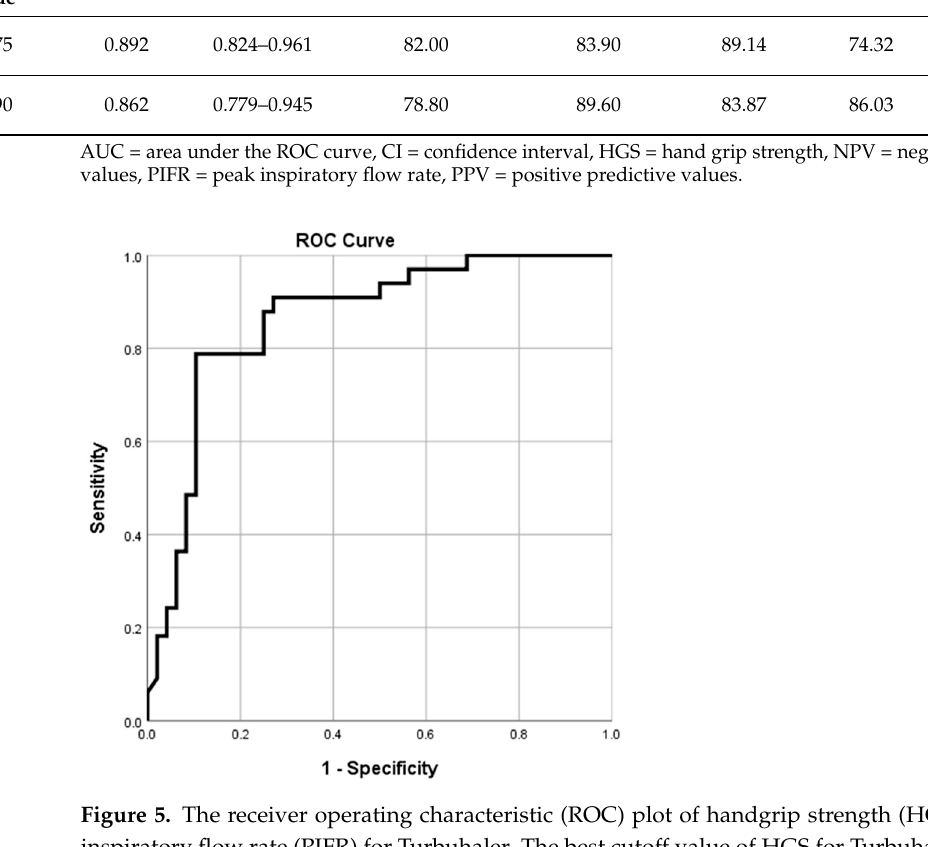
Table 5. Cutoff values of hand grip strength for predicting optimal Accuhaler and Turbuhaler PIFR. Variable